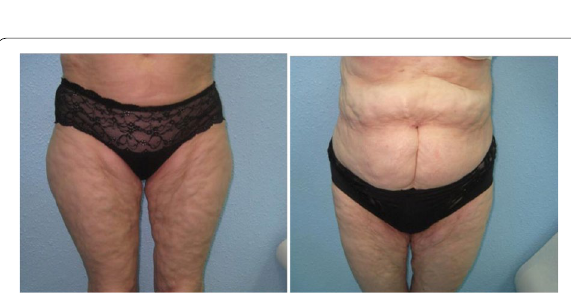
Fig. 4 Chronic GVHD‑related EF: skin rippling on the anterior aspect of the thighs and on the abdomen. Skin is not